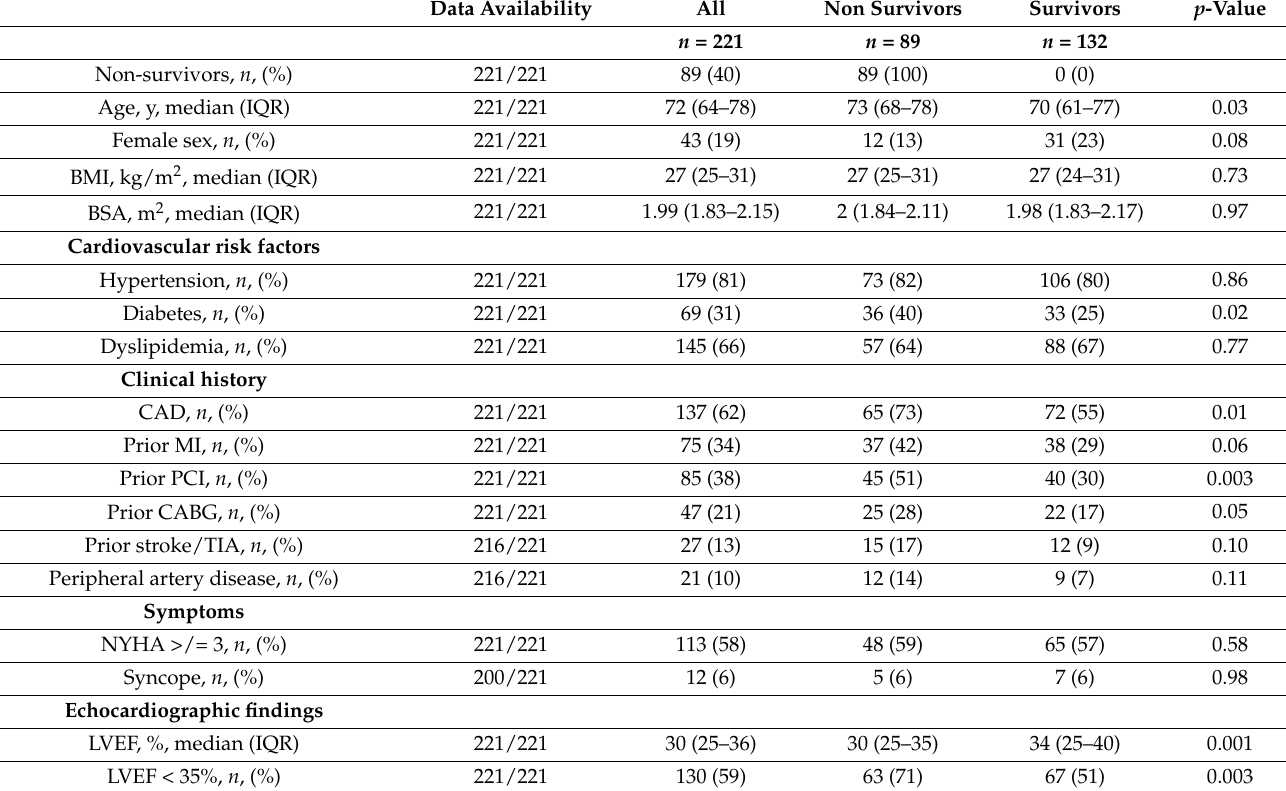
Table 3. Clinical characteristics of the TAPSE/PASP subgroup as part of the validation